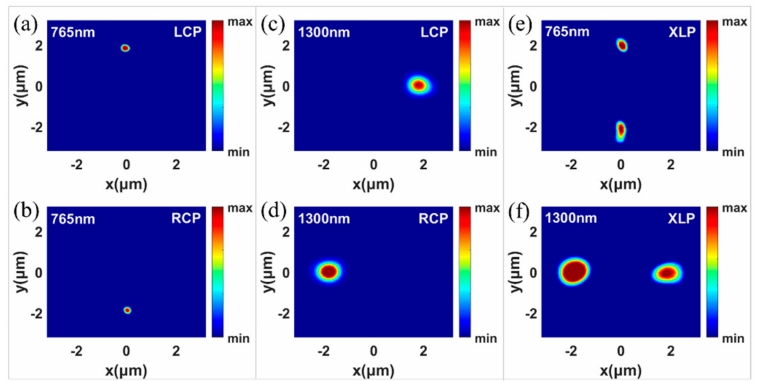
Figure 6. Simulated intensity distributions in the X–Y plane of 3D metalens with four focuses under the LCP of 765 nm ( a ), RCP of 765 nm ( b ), XLP of 765 nm ( c ), LCP of 1300 nm ( d ), RCP of 1300 nm ( e ) and, XLP of 1300 nm ( f ) illuminations.